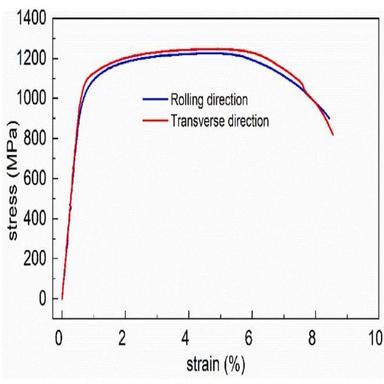
Microstructure of the as-received DP 1180 steel: (a) typical SEM image of microstructure (ferrite is marked by red arrows) of the as-received material; (b) band contrast map (austenite is marked by green color); (c) SEM image of the coated zinc layer on DP steel obtained using backscatter electron (BSE) detector. (For interpretation of the references to color in this figure legend, the reader is referred to the Web version of this article.)